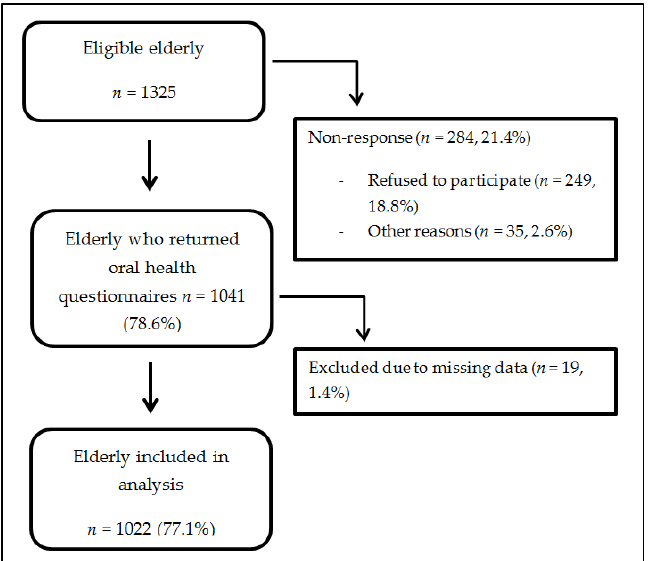
Figure 1. Flow diagram of patient inclusion process.